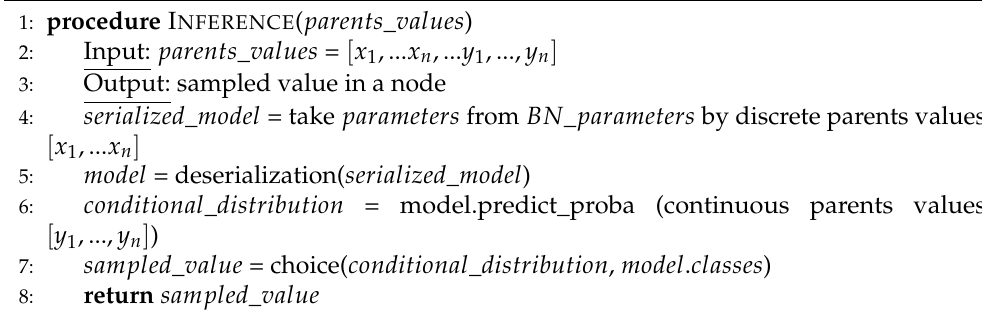
Algorithm 4 Inference for discrete nodes in BNs with